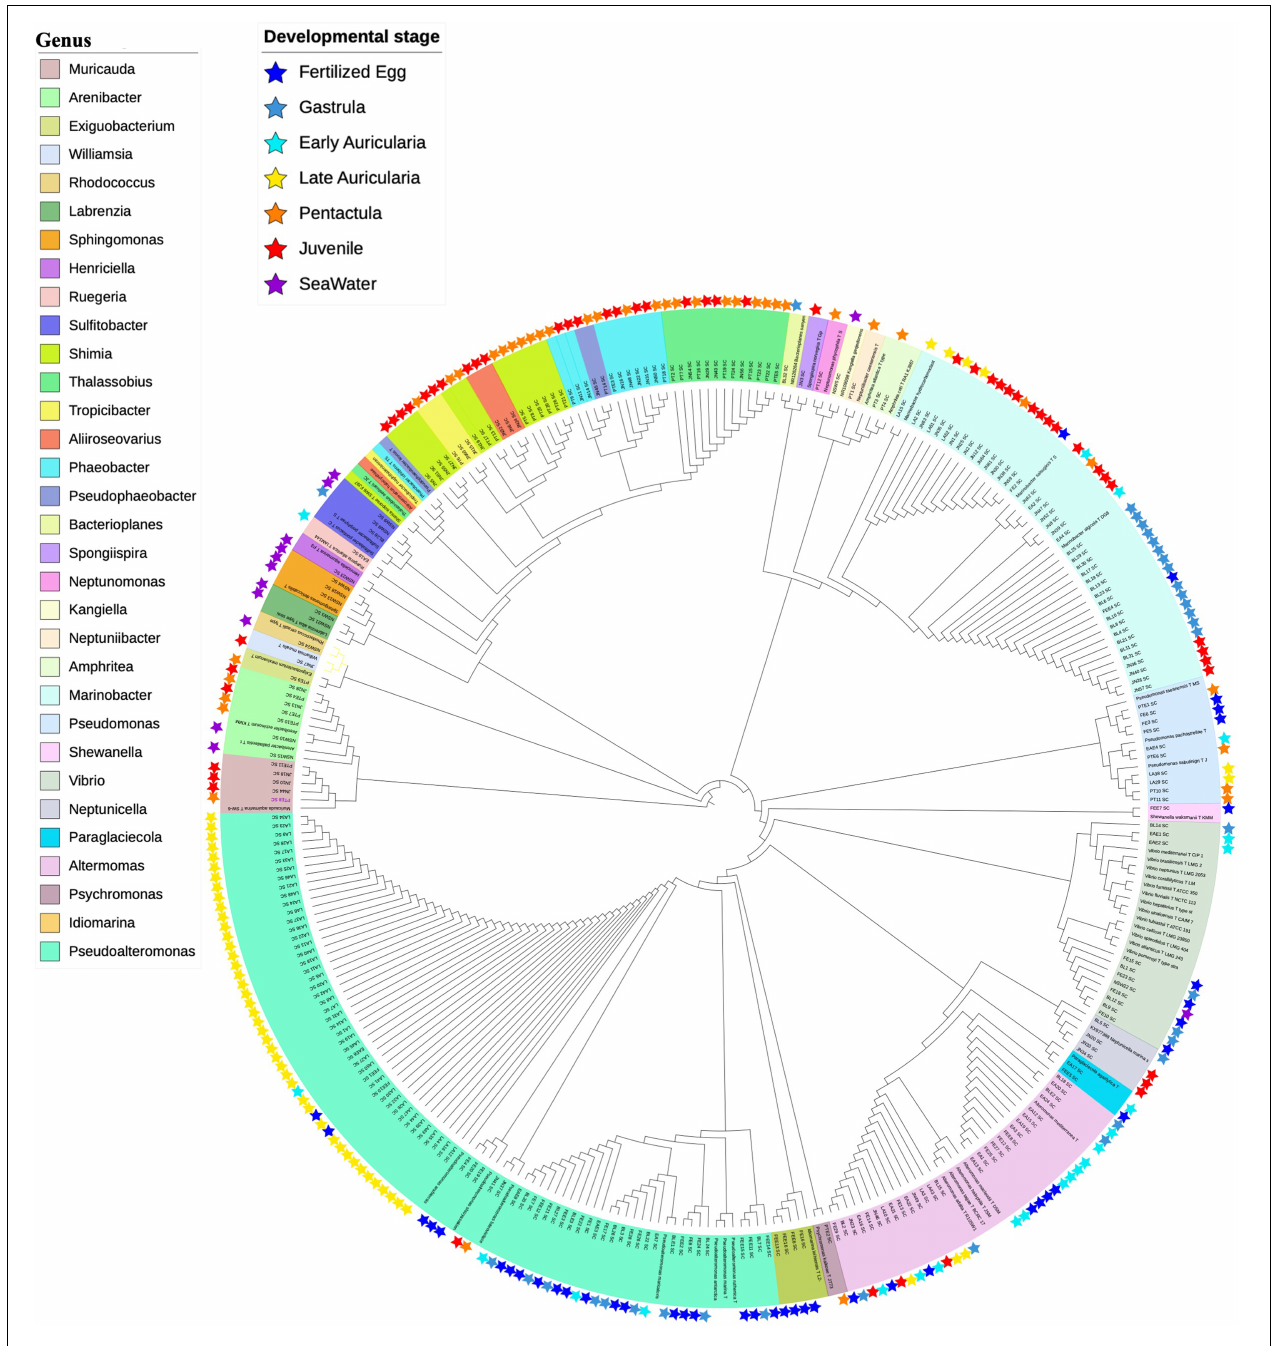
FIGURE 9 | Maximum-Likelihood phylogenetic tree based on partial 16S rRNA gene sequences of isolates. Isolates were shown with stars in specific color. Different genera were labeled with different color. 257 isolates were assigned to 32 genera and 45 species.